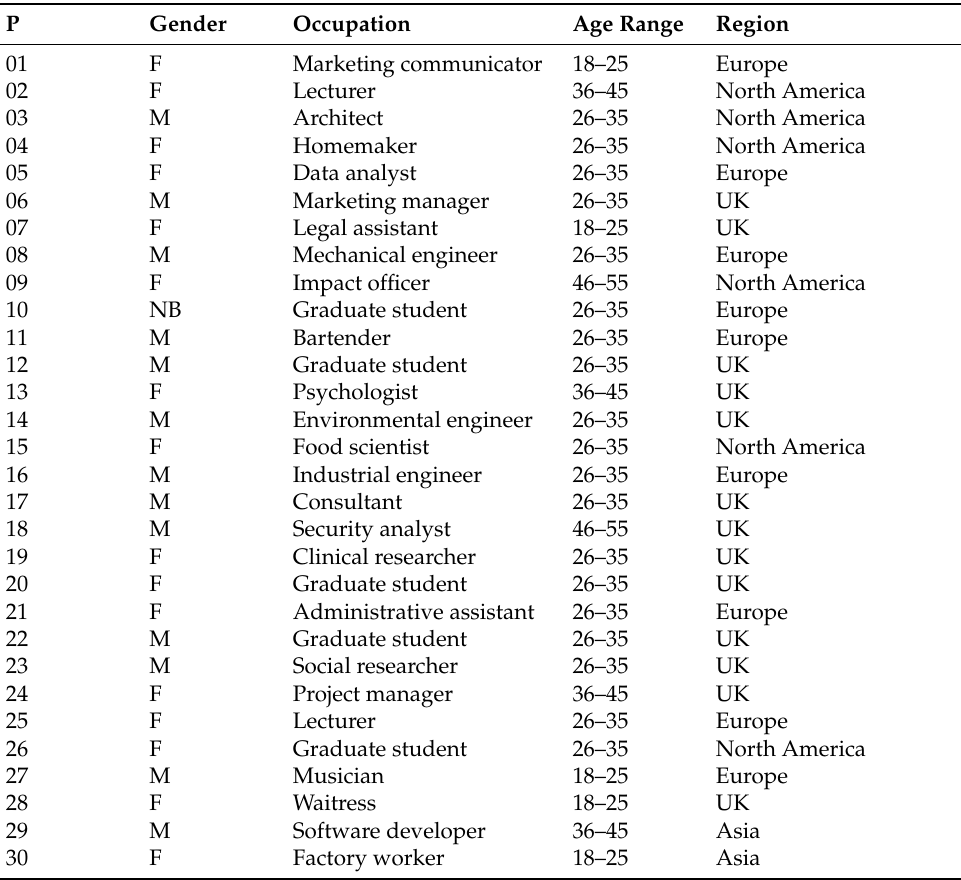
Table 1. Workshop